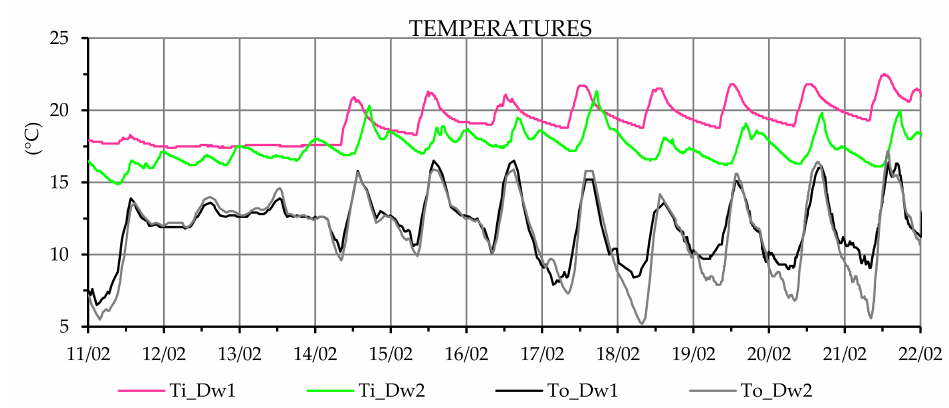
Figure 5. Dw1 and Dw2 indoor and outdoor air temperature.